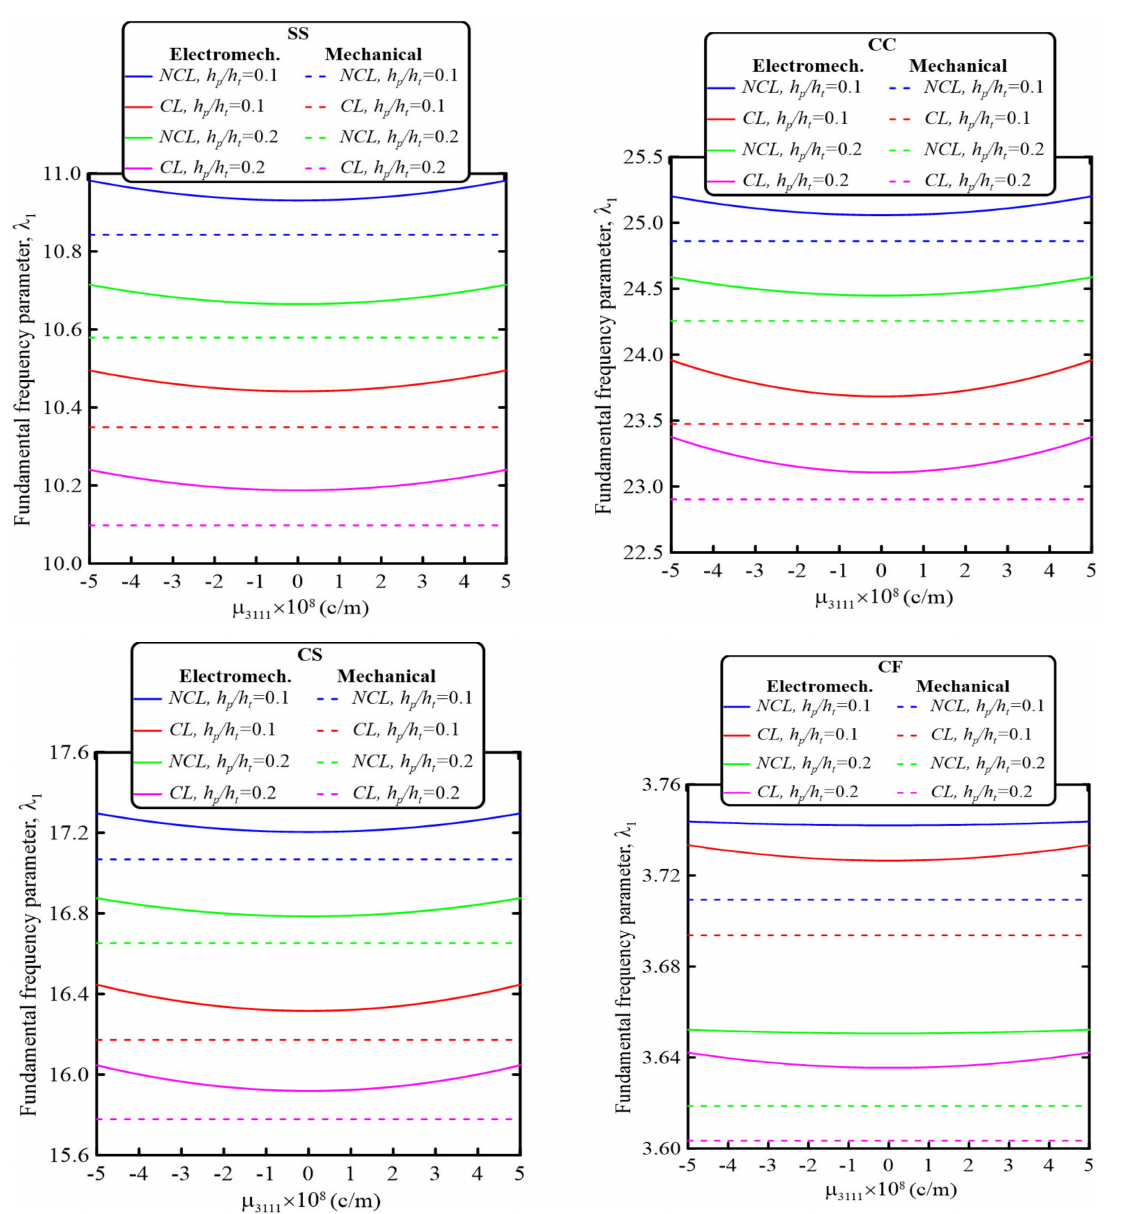
Figure 9. Variation of the fundamental frequency parameter λ 1 with the electric field–strain gradient coupling coefficient µ 3111 for nonclassical and classical electromechanical and mechanical analyses of piezoelectric sandwich nanobeams at different ratios of the piezoelectric layer thickness to the total beam thickness h p / h t for different beam boundary conditions at α = 0.5 and beam aspect ratio, L / h t = 20 (N = 4, e 0 a = 0.5 nm, l = 5 nm, e 311 = − 4.1 C/m 2 , a 33 = 7.124 × 10 -9 C/m 2